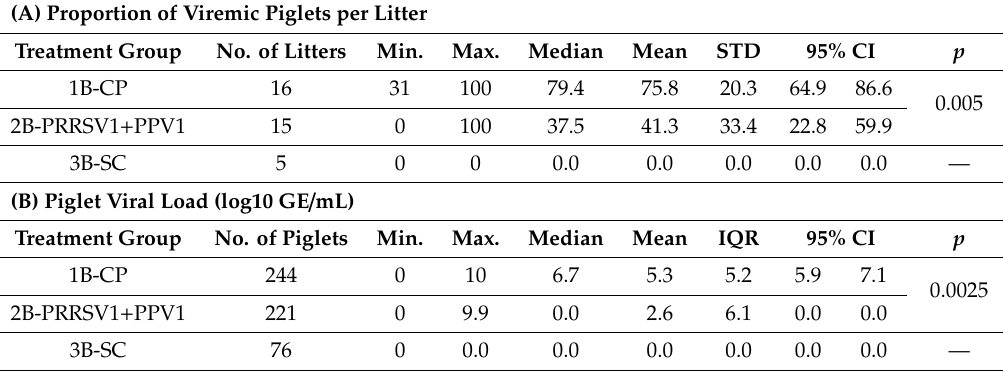
Table 2 . Summary statistics for the proportion (%) of viremic piglets per litter (A) and piglet viral loads (Log10 GE/mL; B) at birth from experiment B. PRRS viral RNA load in sera or lung tissue was assessed using RT-qPCR. Generated data in log10 GE/mL were used for comparisons of median values between groups using the Wilcoxon Mann – Whitney test. Min. = minimum value, Max. = maximum value, STD = standard deviation, IQR = interquartile range, CI = confidence